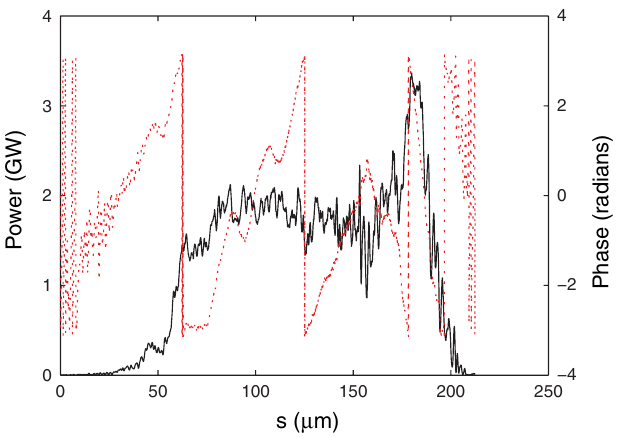
FIG. 9. (Color) Start-to-end, self-seeding: single shot radiation power (black solid line) and phase (red dashed line) along the beam at saturation in the second undulator ( z ¼ 20 : 5 m